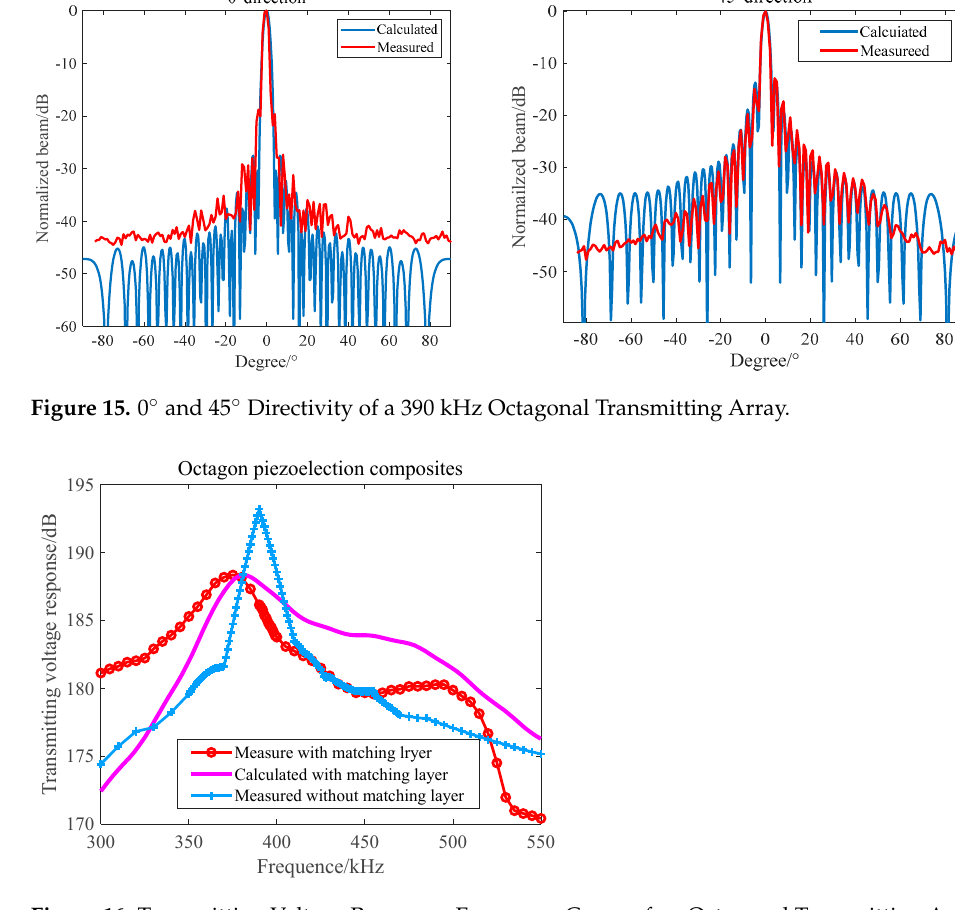
Figure 15. 0° and 45° Directivity of a 390 kHz Octagonal Transmitting Array.